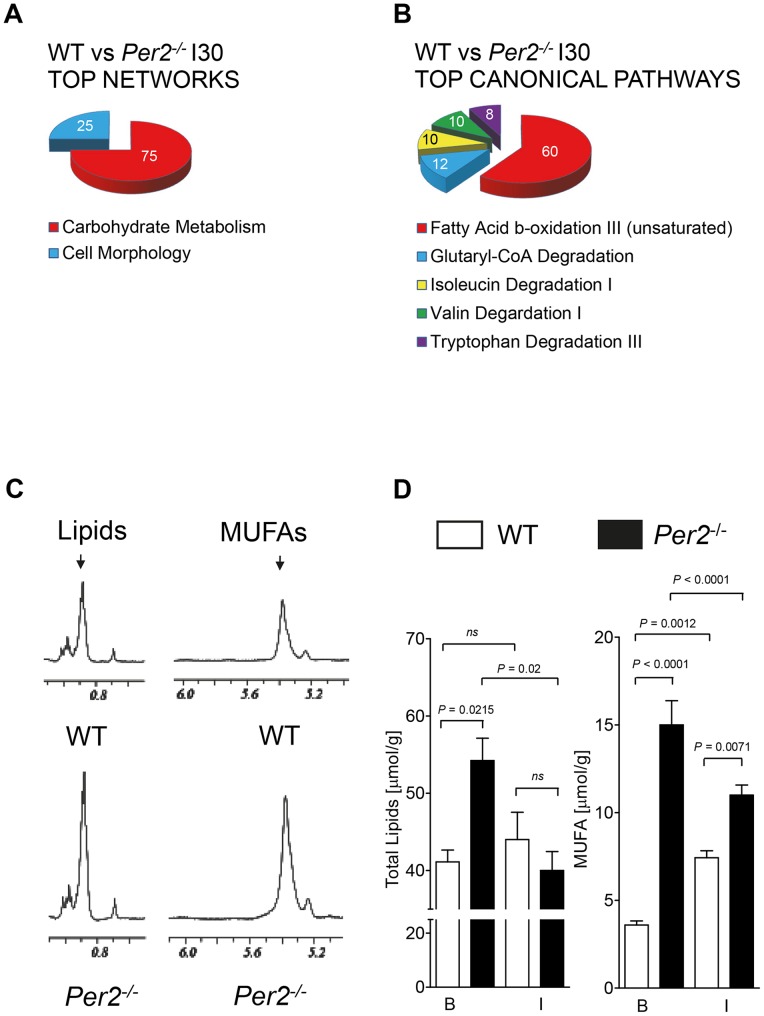
Disrupted fatty acid metabolism in Per2
−
/− mice during myocardial ischemia.(A, B) Pathway analysis comparing wildtype and Per2−/− mice after 30 minutes of ischemia without reperfusion. Differentially regulated genes and pathways were analyzed using Partek and Ingenuity software, respectively. (C) Fatty acid subpopulation analysis in wildtype and Per2−/− hearts at baseline using nuclear magnet resonance (NMR) technique. Representative NMR spectra for total lipids or monounsaturated fatty acids (MUFAs) at baseline are displayed. To calculate an absolute monounsaturated fatty acid (MUFA) concentration, the concentration of polyunsaturated fatty acids, triacylglycerides and glycerides are subtracted from the total for this peak. (D) WT or Per2−/− mice were exposed to 30 minutes of ischemia without reperfusion. Shock frozen hearts were analyzed for total lipid and MUFA content at baseline (B) and Ischemia (I) using NMR, n = 3 mice in all groups.